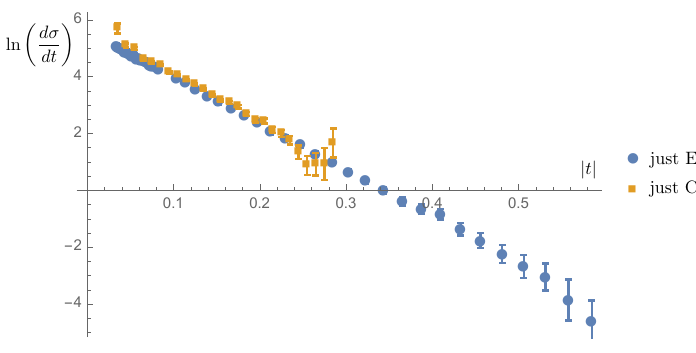
Figure 5 . The discrepancy between the CDF and E710 data at p s = 1800 GeV. params. 1st local minimum 2nd local minimum